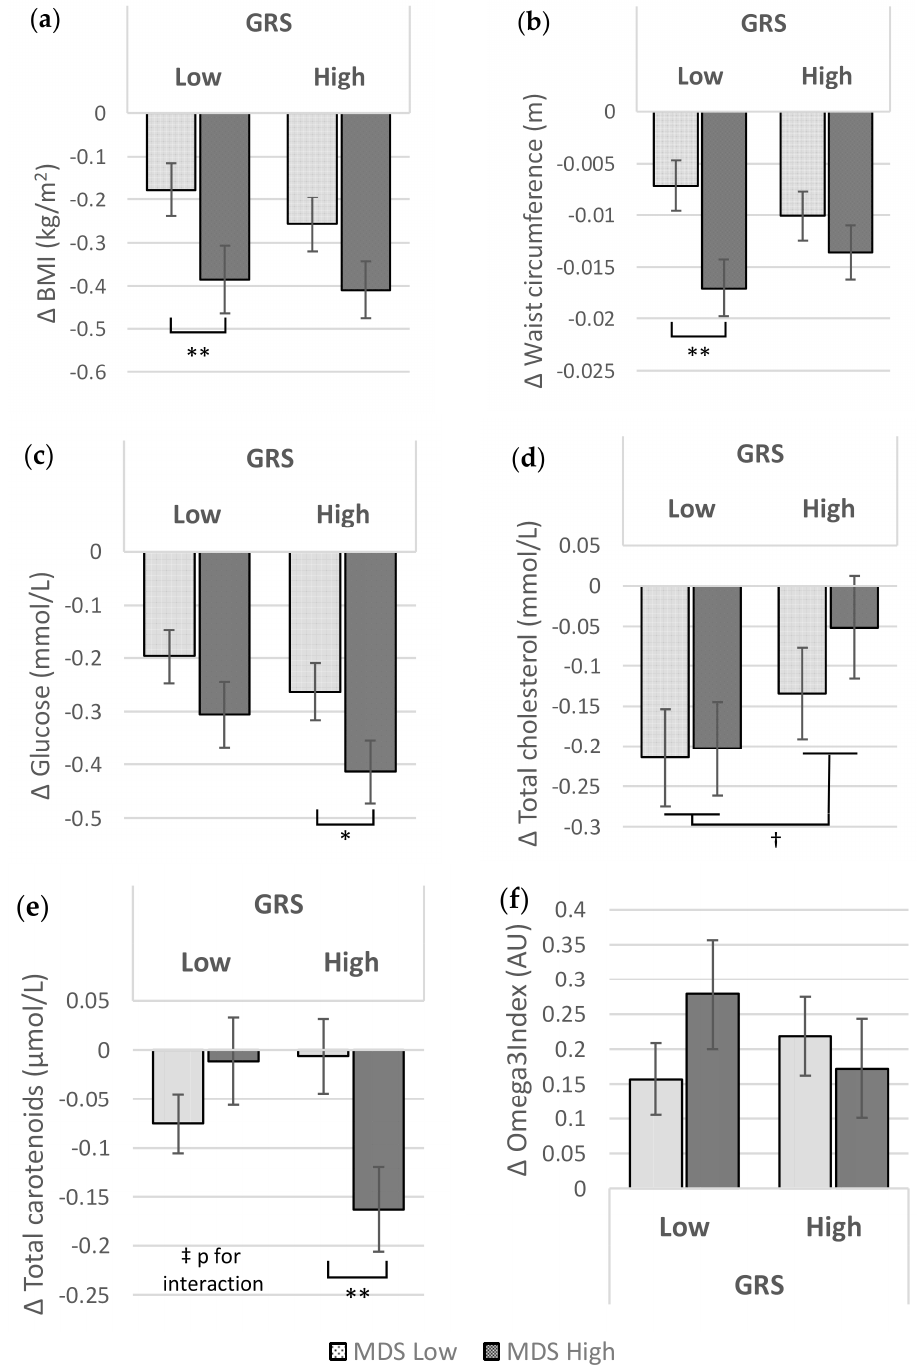
Figure 2. Differences in metabolic traits after the intervention (month 6 vs. baseline) between MDS levels, at each GRS level and differences between GRS levels, adjusted by age, gender, physical activity, country, ethnicity, smoking habit and energy intake reported: ( a ) BMI: p -value for interaction 0.688; ( b ) Waist circumference: p -value for interaction 0.226; ( c ) Glucose: p -value for interaction 0.718; ( d ) Total cholesterol: p -value for interaction 0.567; ( e ) Total carotenoids: p -value for interaction 0.006; ( f ) Omega3 index: p -value for interaction 0.209. *, ** and *** represent p -values less than 0.1, 0.05 and 0.001, respectively, for differences between MDS levels in each GRS level; and † represents p -values less than 0.05 for differences between GRS levels. ‡ p -value less than 0.05 for MDS × GRS interaction. MDS: Mediterranean Diet Score; GRS: Genetic Risk Score; AU: Arbitrary